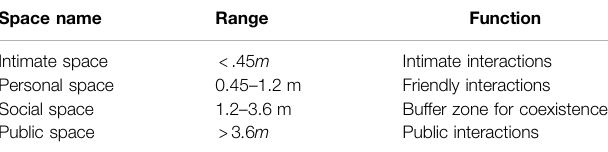
TABLE 7 | Interpersonal spaces as de fi ned by Hall